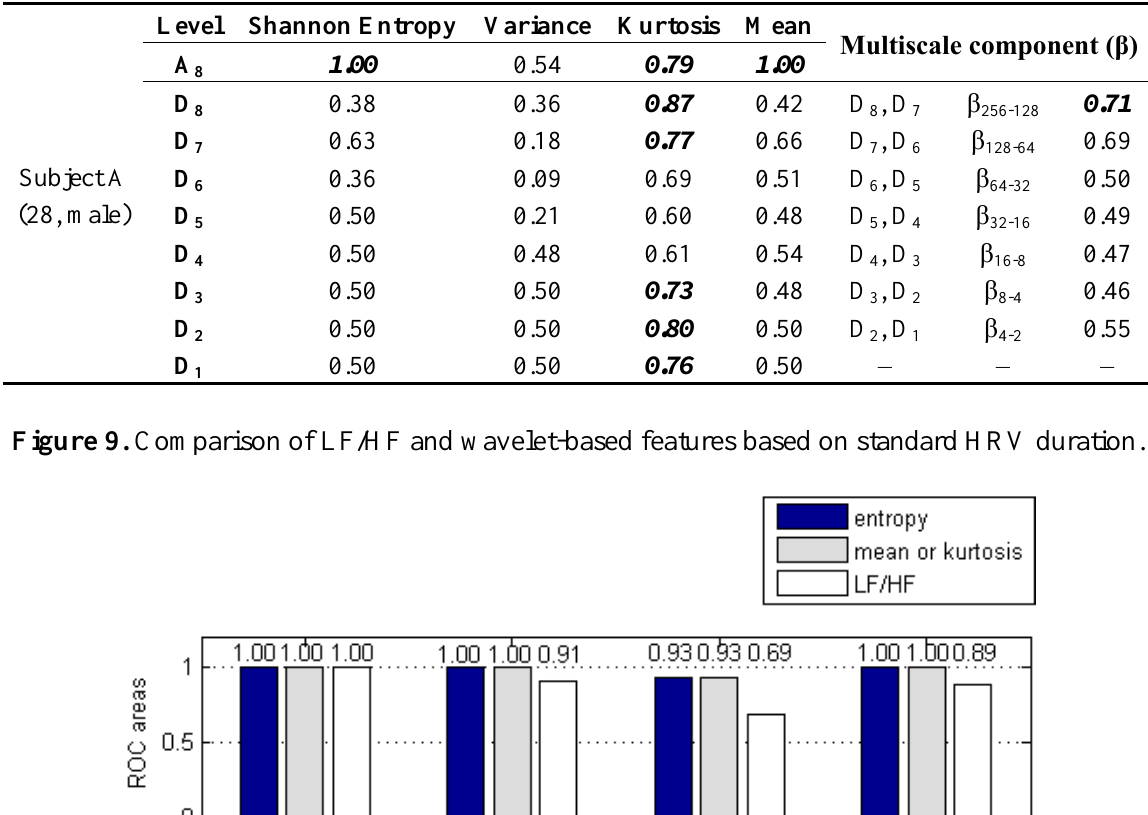
Table 6. Example of the ROC areas for all 43 wavelet-based features based on 1-min HRV durations.